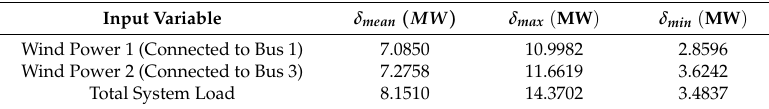
Table 3. Statistics of standard deviation values for all clusters.